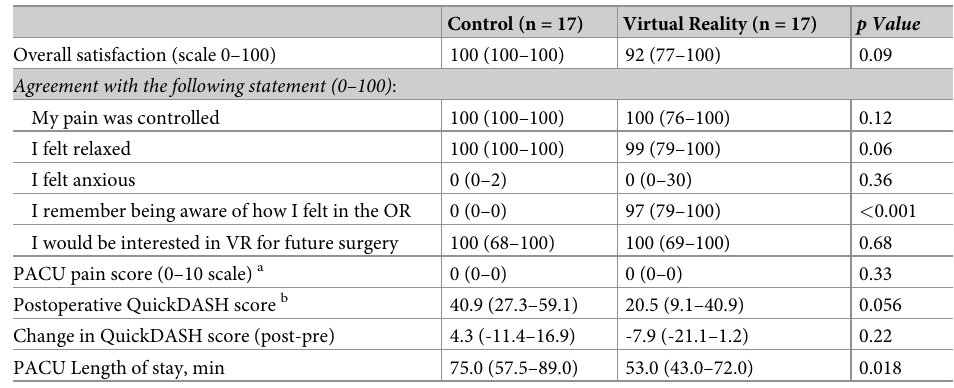
Table 3. Postoperative